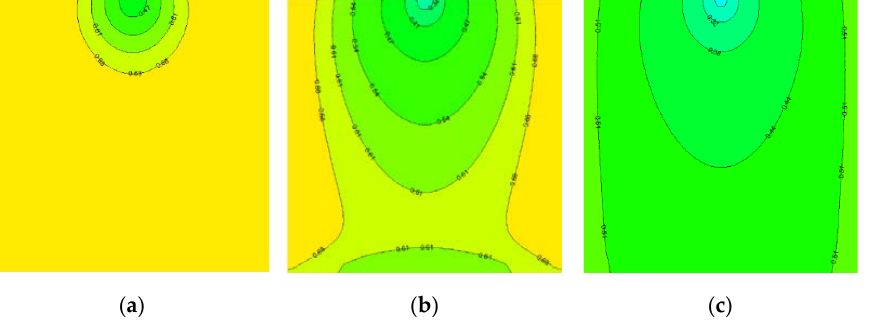
Figure 13. Remaining oil distribution of each layer after water flooding stage of Figure 3: ( a ) low-